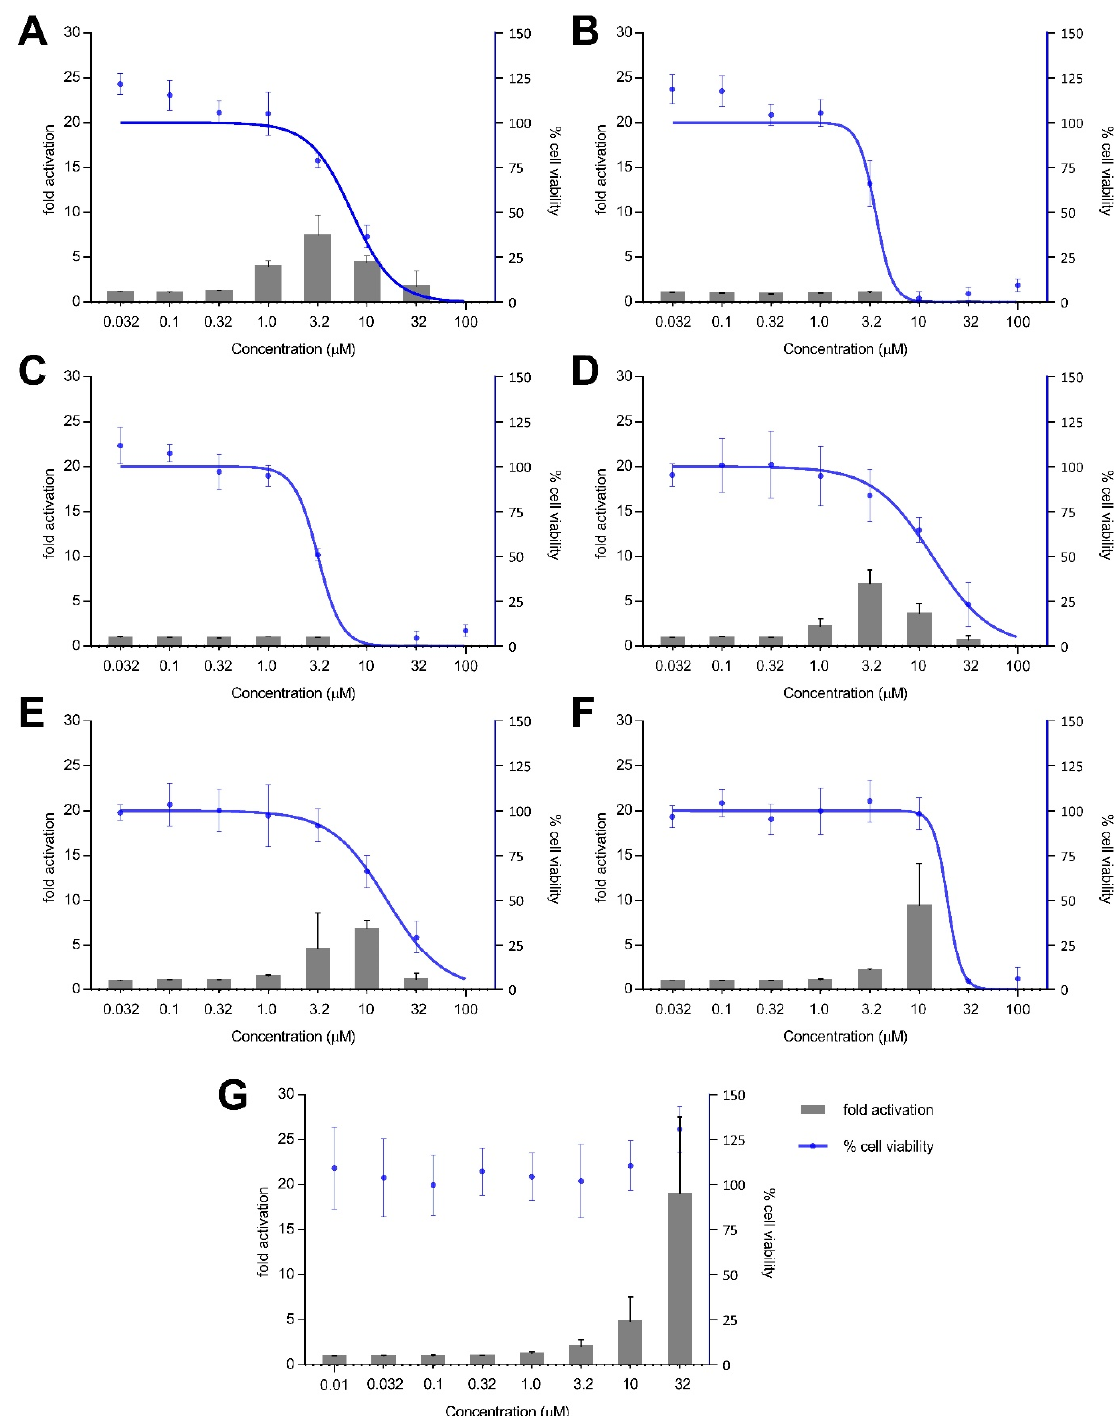
Figure 5. Nrf2-ARE fold activation (bar graph) and cell viability (line graph) effects of ( A ) xestoquinone ( 1 ), ( B ) adociaquinone B ( 2 ), ( C ) adociaquinone A ( 3 ), ( D ) 14-hydroxymethylxestoquinone ( 4 ), ( E ) 15-hydroxymethylxestoquinone ( 5 ), ( F ) 2:1 14-methoxyxestoquinone and